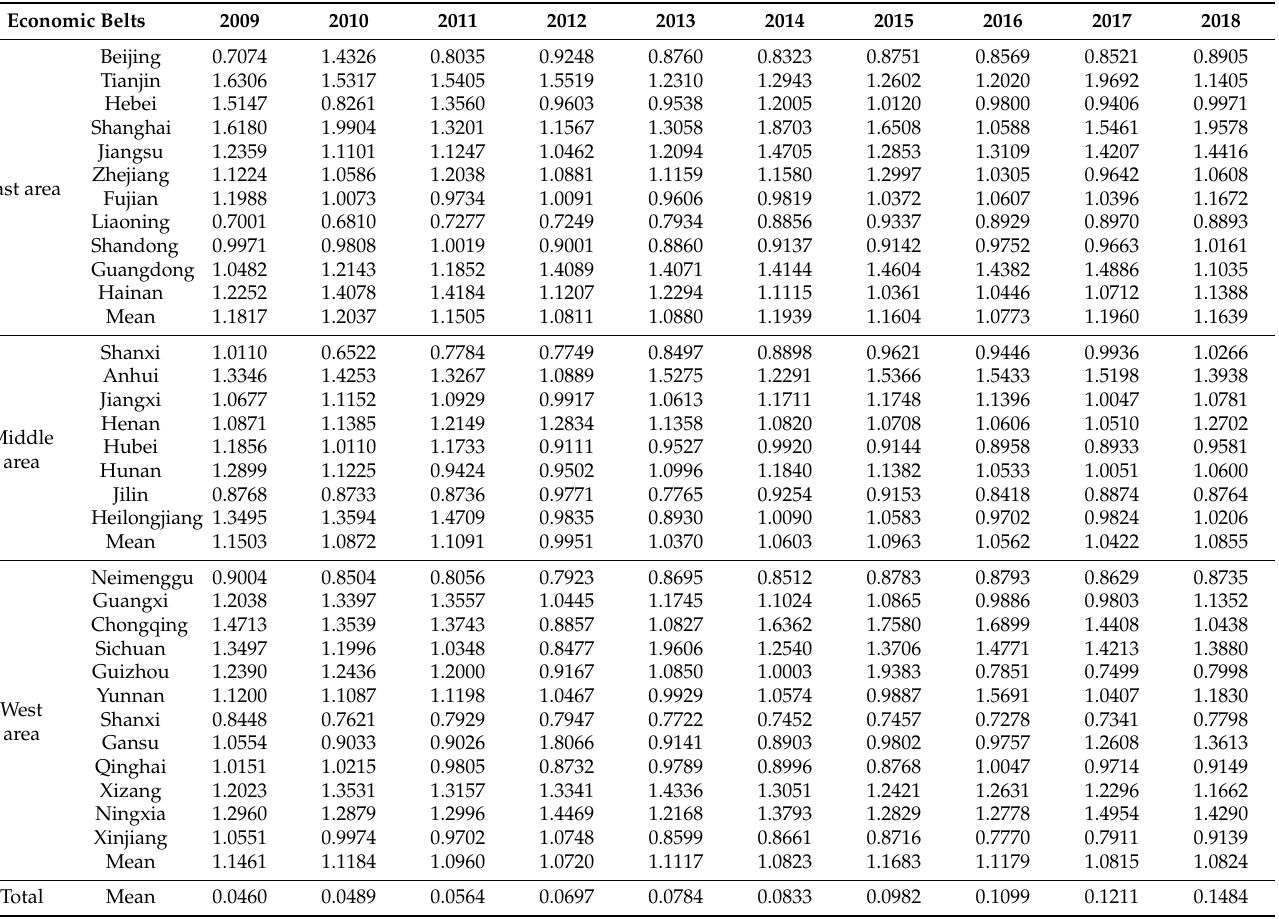
Table A3. The efficiency of the provision of public health services in China’s 31 provinces from 2009 to